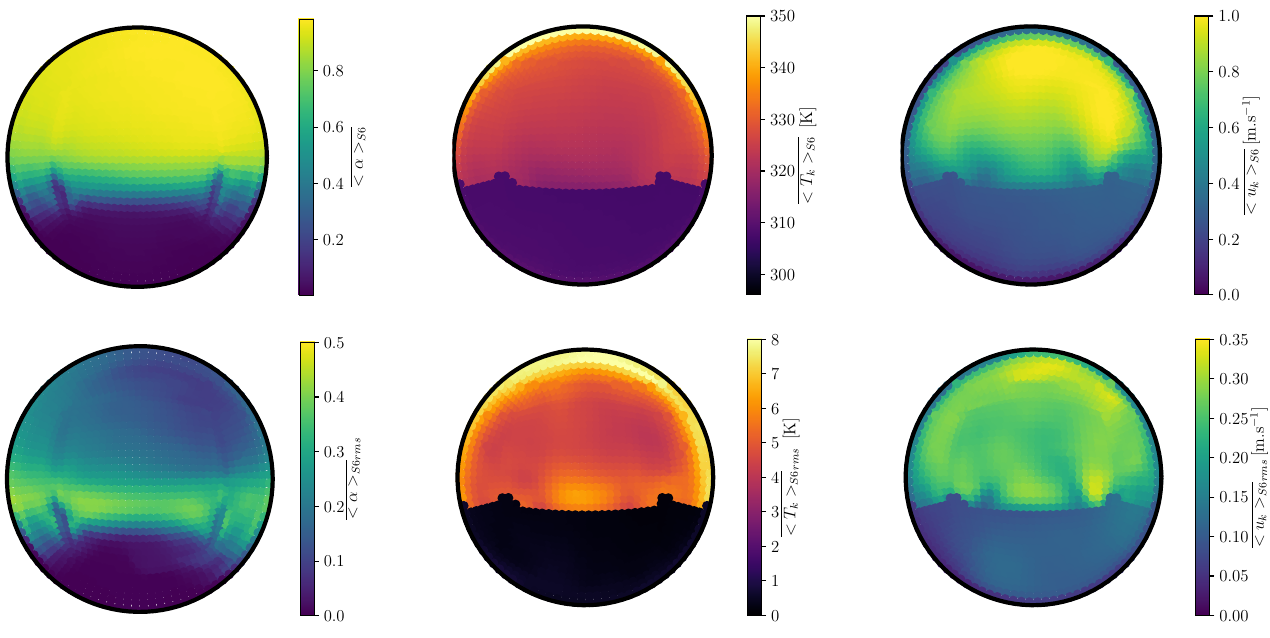
Figure 9. Average and RMS fields in section S6: void fraction, temperature and streamwise velocity. The top line shows the average fields, while the bottom one presents the associated